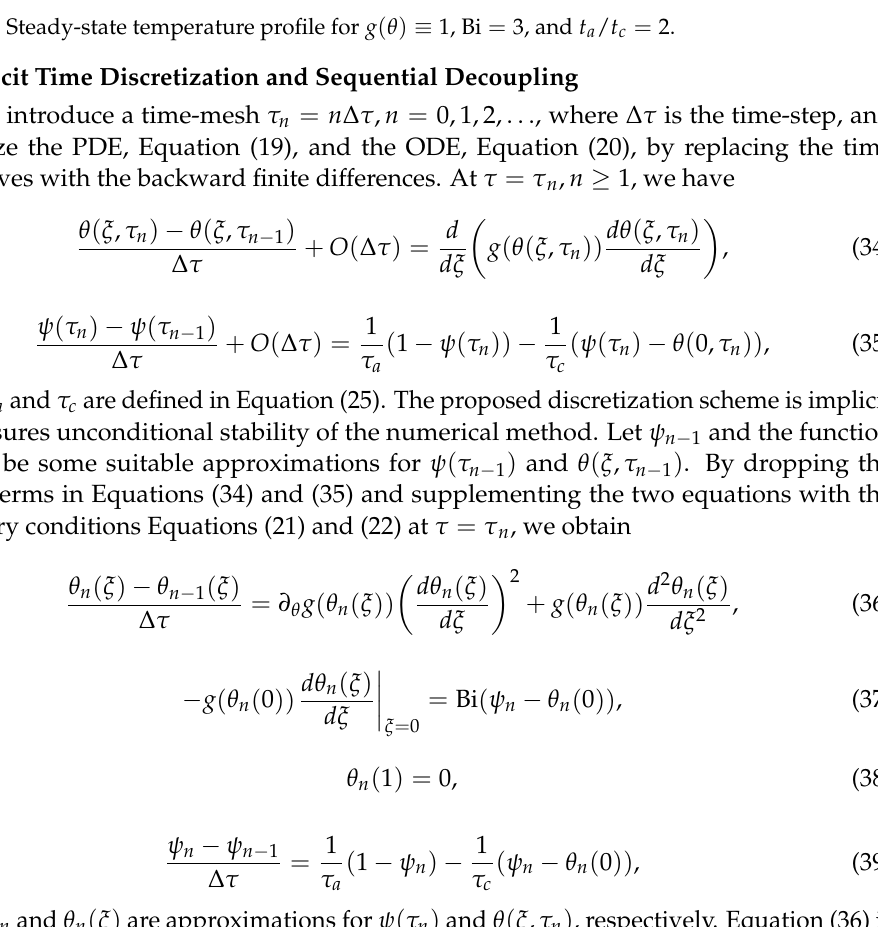
Figure 2. Steady-state temperature profile for 𝑔(𝜃) ≡ 1 , Bi = 3 , and 𝑡 𝑎 /𝑡 𝑐 = 2 .